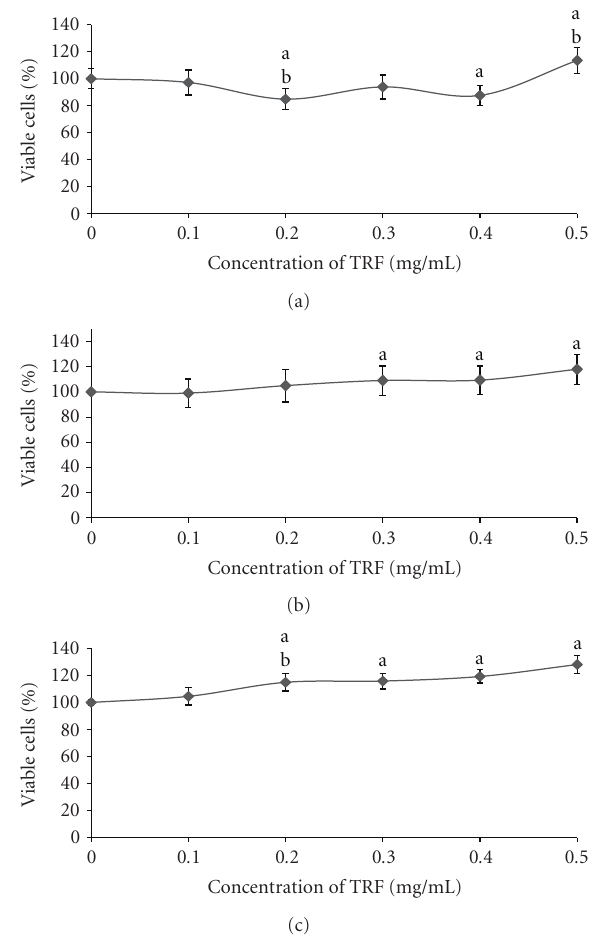
Figure 1: Dose response of tocotrienol-rich fraction (TRF) on young (a), presenescent (b), and senescent (c) HDFs after 24 h incubation at 37 ◦ C. Incubation with TRF caused a significant increase in the viability of HDFs. a Denotes P < . 05 compared to control, b P < . 05 compared to lower concentration. Data are presented as mean ± SD, n =